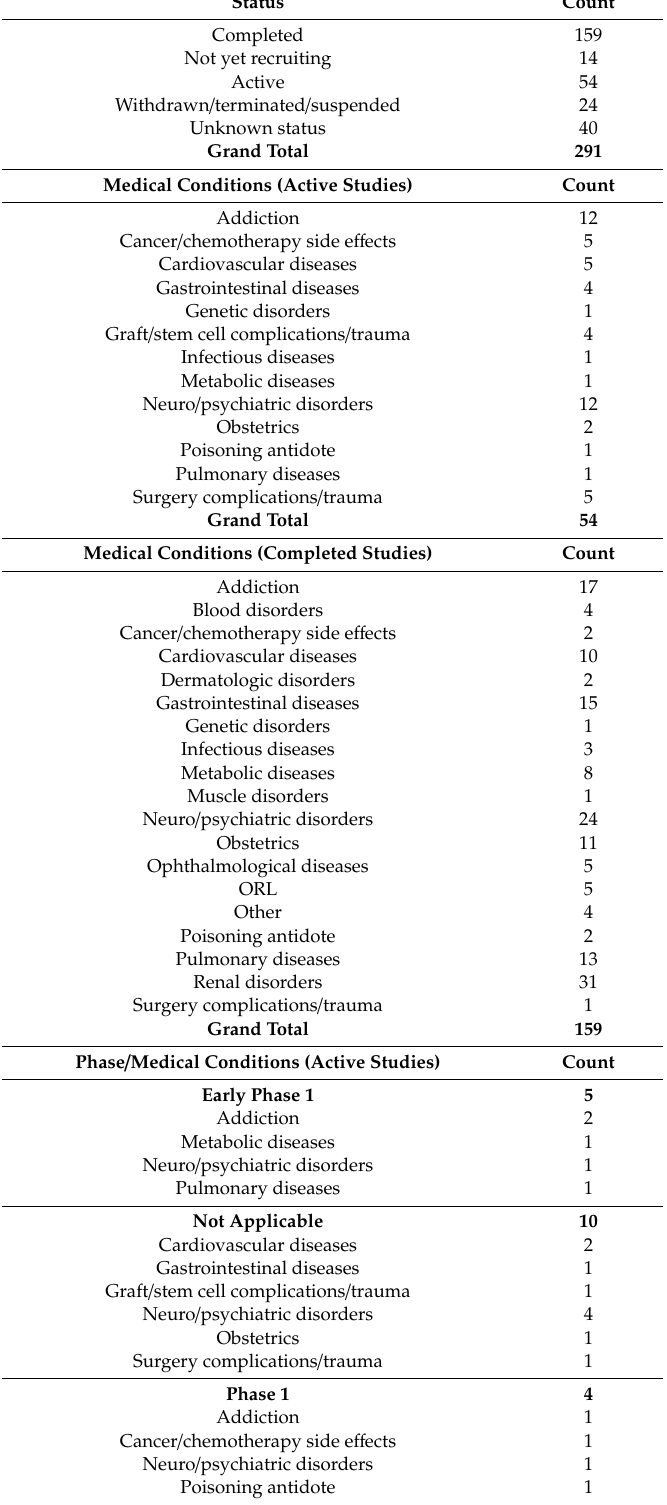
Table 2. NAC clinical trials registered at ClinicalTrials.gov [48]. The number of studies is displayed according to the study status, tested medical conditions of currently active studies, tested medical conditions in completed studies, study phase and tested medical conditions of currently active studies, study phase, and tested medical conditions of completed